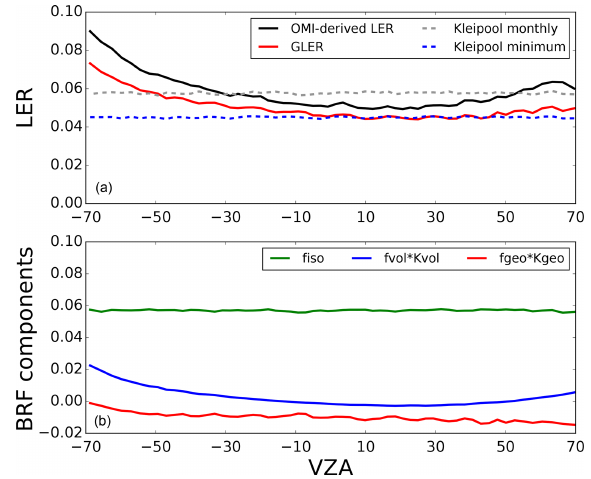
Figure 11. Case study of cross-track (or VZA) dependence for a subregion in western Australia in June–August 2006. The 466nm LER (a) ; BRF components from MODIS data (b) . Positive (nega- tive) VZAs denote forward (backward) scattering